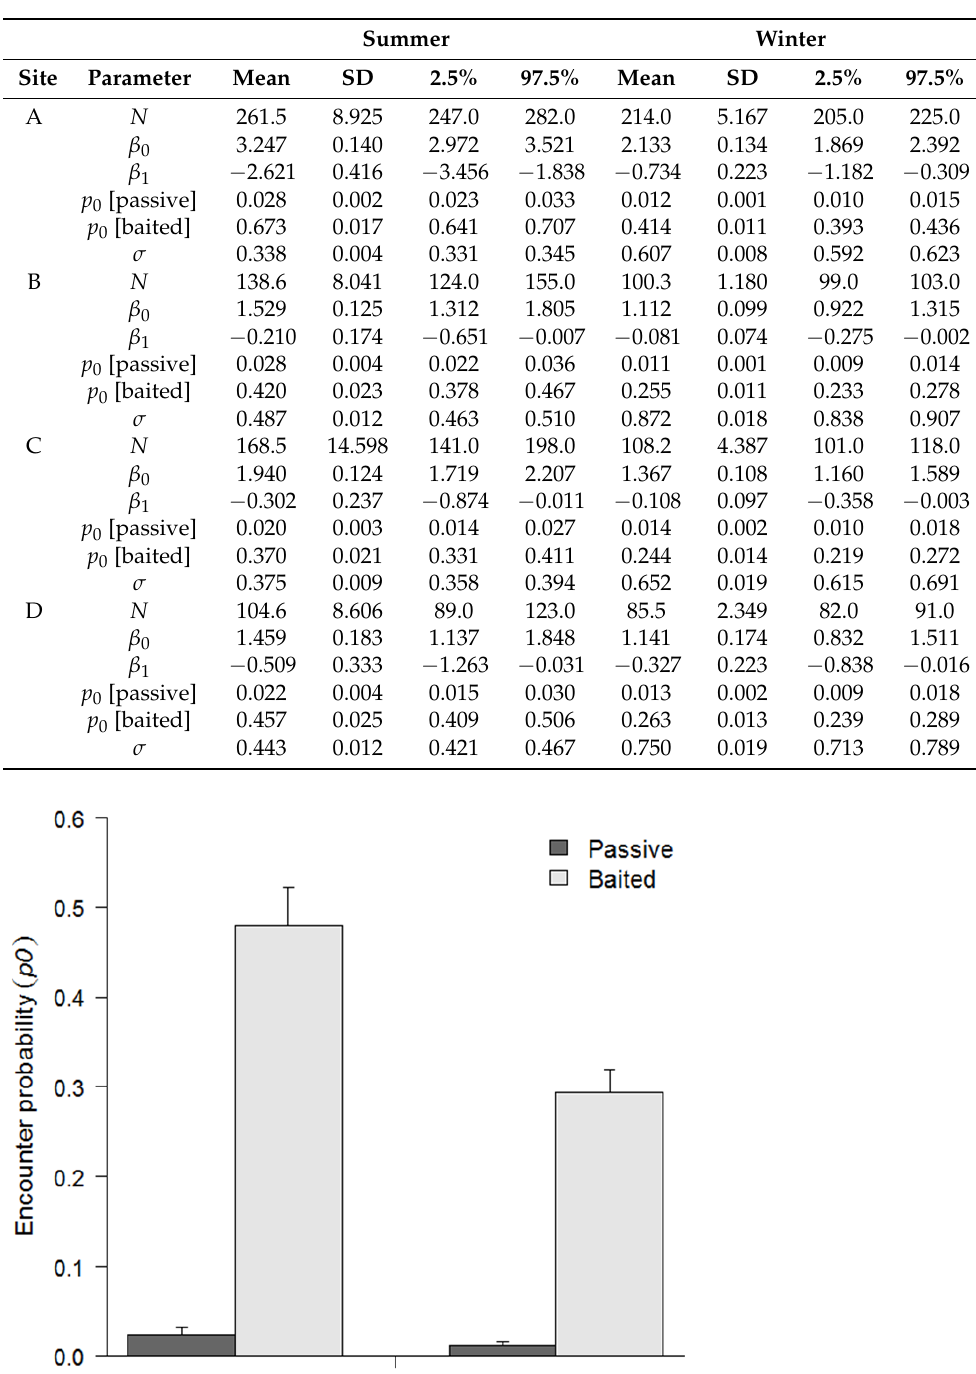
Table 2. Male white-tailed deer spatial-capture recapture parameter estimates. Estimates of the posterior means for male white-tailed deer (Odocoileus virginianus) abundance ( N ), intensity function intercept ( β 0 ), the effect of bait on deer activity center density ( β 1 ), baseline encounter probabilities for both passive ( p 0 [passive]) and baited cameras ( p 0 [baited]), and the scaling parameter of the half- normal detection function ( σ ) from summer (2015) and winter (2016) camera surveys in southwestern Georgia, USA. Summer Winter